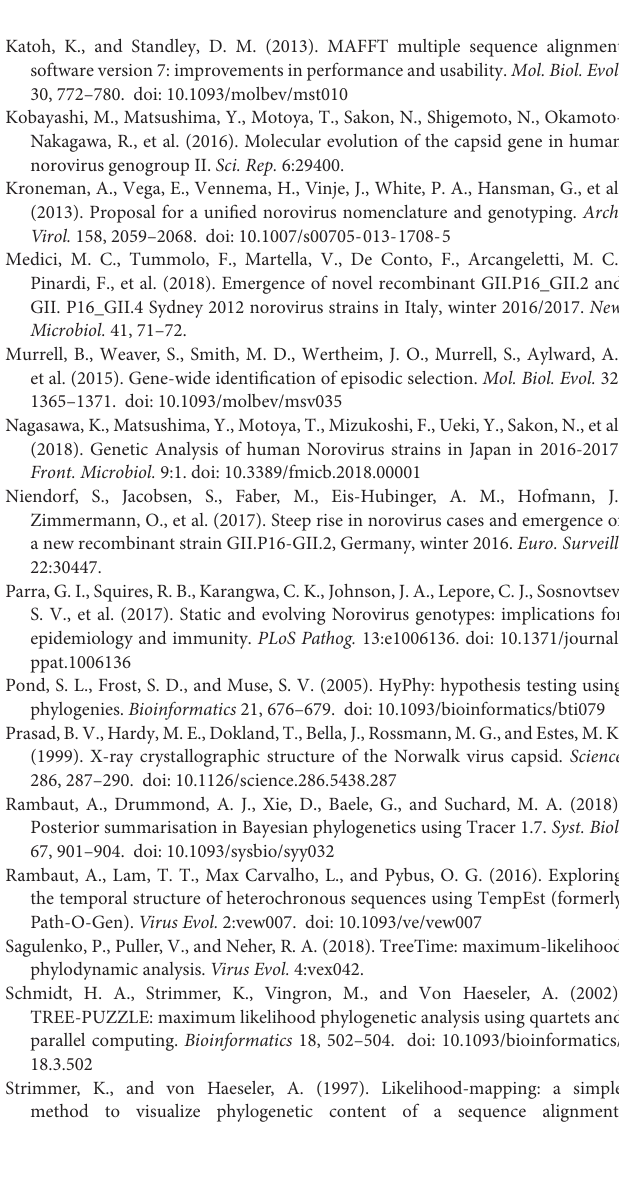
Supplementary Figure 2 | Likelihood-mapping analyses of complete VP1 gene sequences from HuNoV GII.2. Likelihood-mapping analyses were performed for this data set, and also each of eight clusters defined by the maximum-likelihood phylogenetic analyses of complete VP1 gene sequences from HuNoV GII.2. Supplementary Figure 3 | Average pairwise genetic distances within and between HuNoV GII.2 clusters using ggplot2 package. Green and orange colors indicated within and between human norovirus GII.2 clusters. Supplementary Figure 4 | Sampling time interval with respective genetic distance between pairs of HuNoV GII.2 clusters. Green and orange colors indicated within and between HuNoV GII.2 clusters. Supplementary Figure 5 | Estimated time to the most recent common ancestor of each HuNoV GII.2 cluster. Clusters were shown with different colors. Supplementary Figure 6 | Estimated effective population size through time using Bayesian Gibbs-within-Metropolis MCMC and fast maximum a posteriori algorithm. Estimated effective population size through time was based on the tree in Supplementary Figure 1